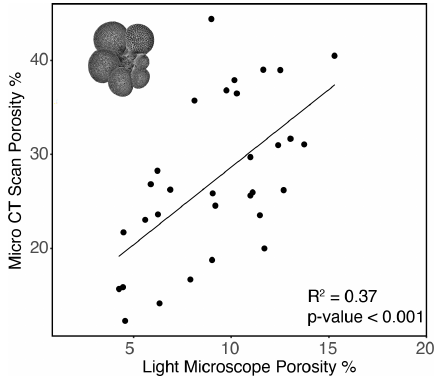
Figure 7. Relationship between G. hexagonus final chamber porosity measured by light microscope and CT scan ( R 2 = 0 . 45, p value < 0.001). A representative image reconstructed from CT scanning is inset in the upper left corner.